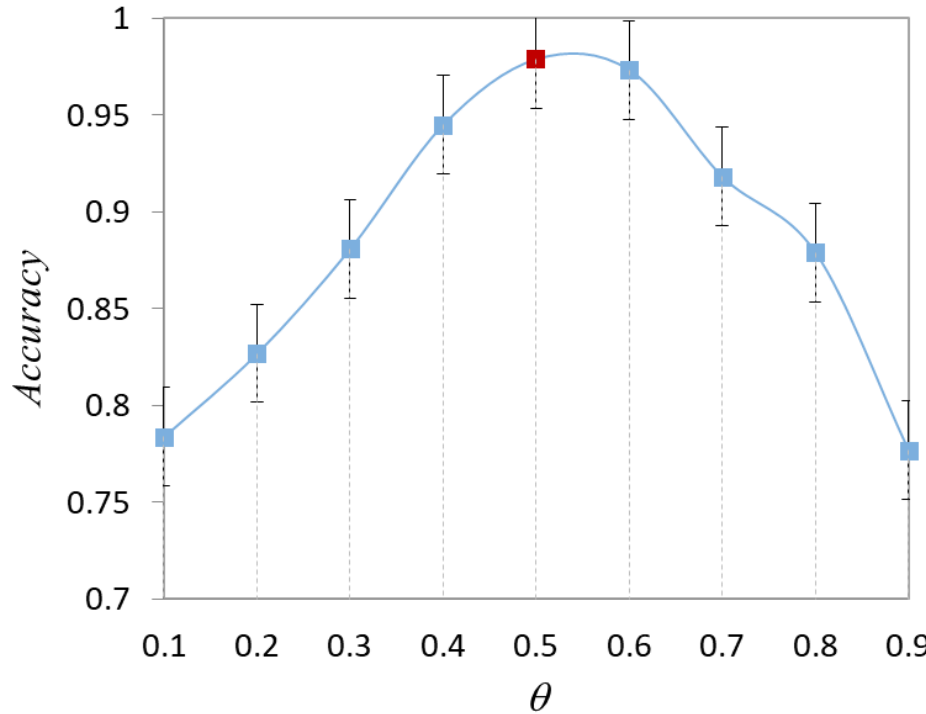
Figure 5. Effect of parameter 𝜃 on model accuracy.